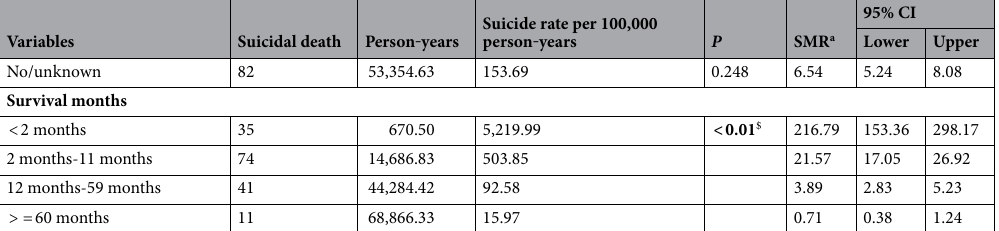
Table 2. Suicide rates and SMRs among patients with esophageal cancer by demographic and clinic characteristics (1975 ‐ 2016). SMR, standardized mortality ratio; SEER, the surveillance, epidemiology, and end results program; 95% CI, 95% confidence interval; NOS, Not Otherwise Specified. a SMR was adjusted by age, race, and sex to the US population over the same time. Five-year age categories were used for standardization using SEER*Stat 8.3.6 and Microsoft Excel 16.0.12730.20188 (Microsoft, Redmond, Washington). b Included divorced, widowed and separated. c Included never married. # The Bonferroni-corrected P value was used for multiple comparisons. $ The chi-square test for linear trend was used for ordinal multi-categorical variables. The P values in the bold are statistically